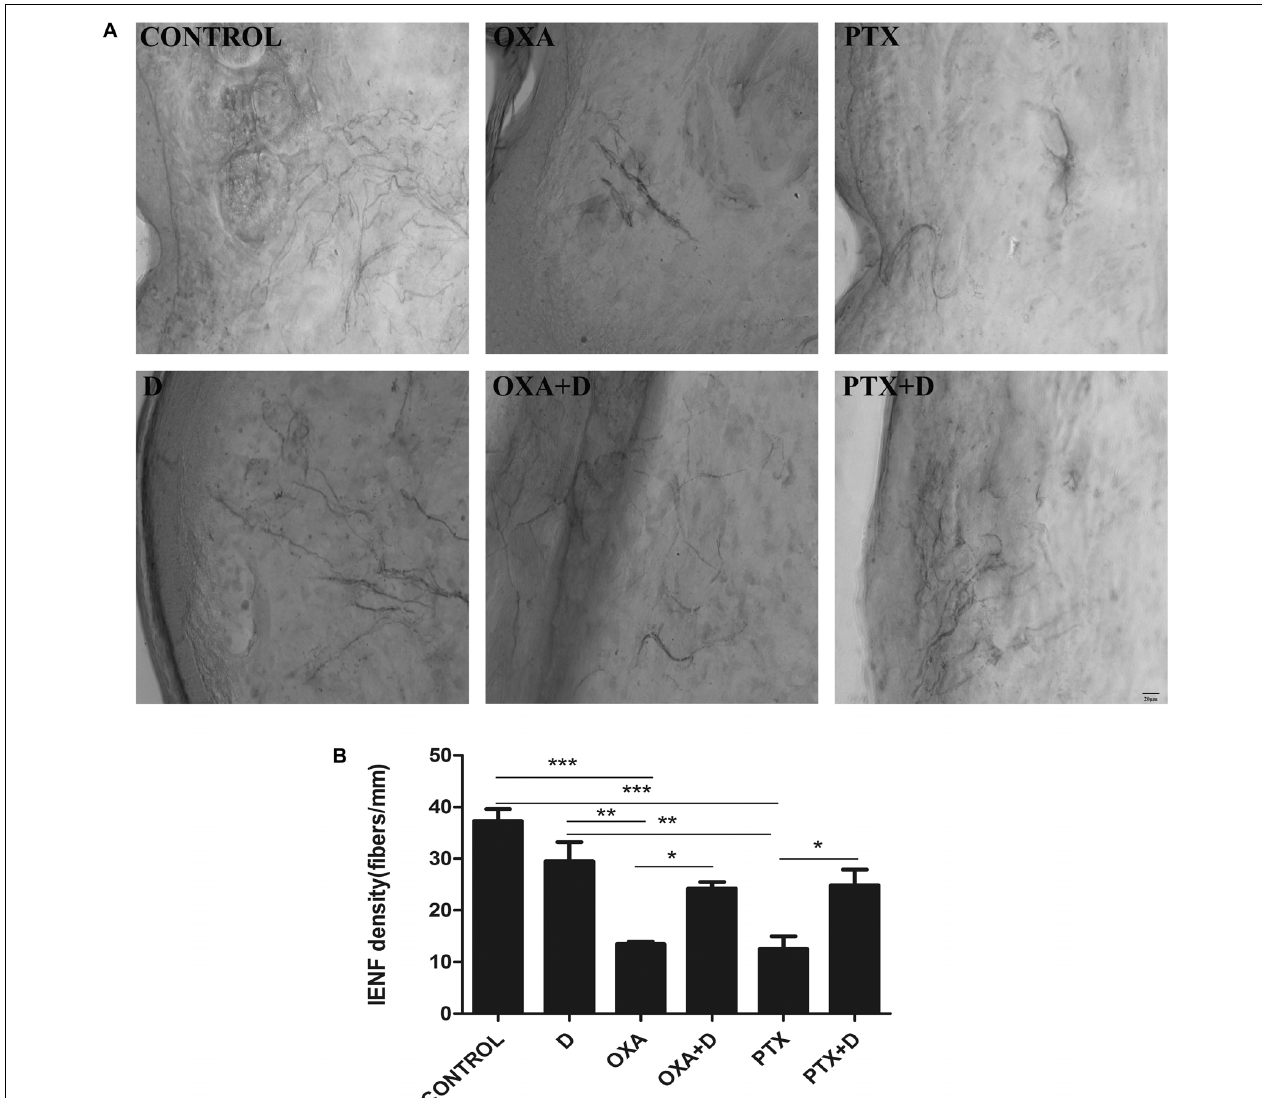
FIGURE 5 | Effect of duloxetine on IENF retraction induced by OXA or PTX. Paw biopsies were obtained from the hind paws of mice when behavior tests were finished. Tissues were fixed and stained with antibodies (PGP9.5) for IENFs. (A) Representative images from six groups are shown. (B) IENF density = number of nerve fibers crossing the basement membrane/length of the basement membrane (mm). (Magnification × 400. ∗ p < 0.05, ∗∗ p < 0.01, ∗∗∗ p < 0.001). The data are presented as the mean ± SEM ( n = 5).